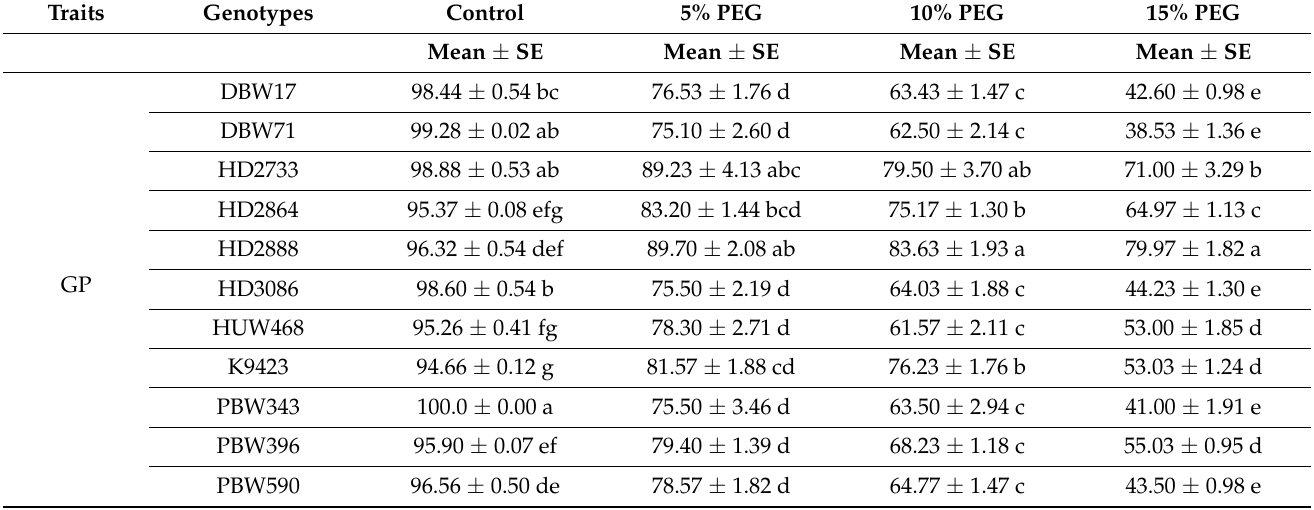
Table 3. Mean values of morphological traits under control and 5%, 10% and 15% PEG treatment